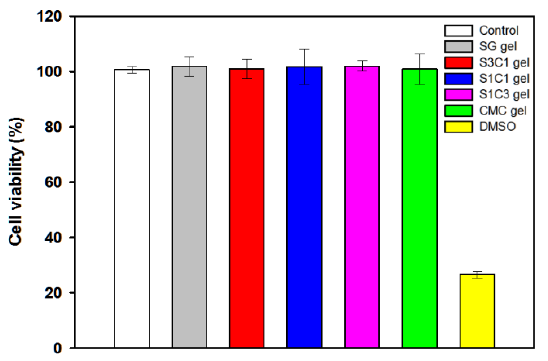
Figure 10. Cytotoxicity of SG/CMC IPN hydrogels against HEK 293 cells.